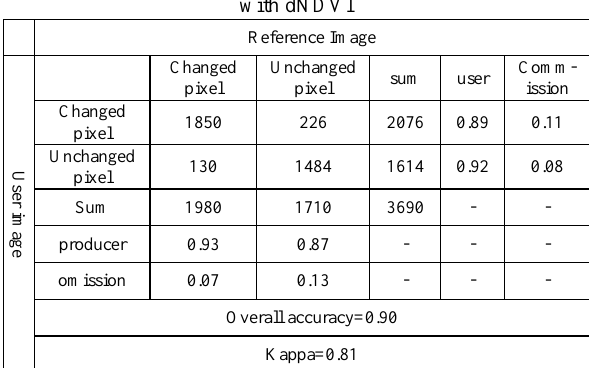
Table 11. Error matrix of object-oriented method with dNDVI As shown in the Figure 10, the distribution of the detected changes (red area) is similar to result of the pixel-based method with dNDVI. Considering that pixel has been merged into homogeneous object before the process of change detection, the